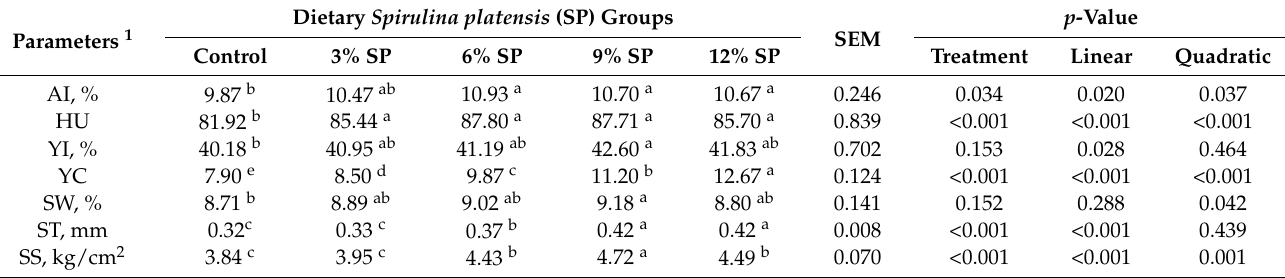
Table 4. Effect of dietary Spirulina platensis on the egg quality parameters of laying hens.